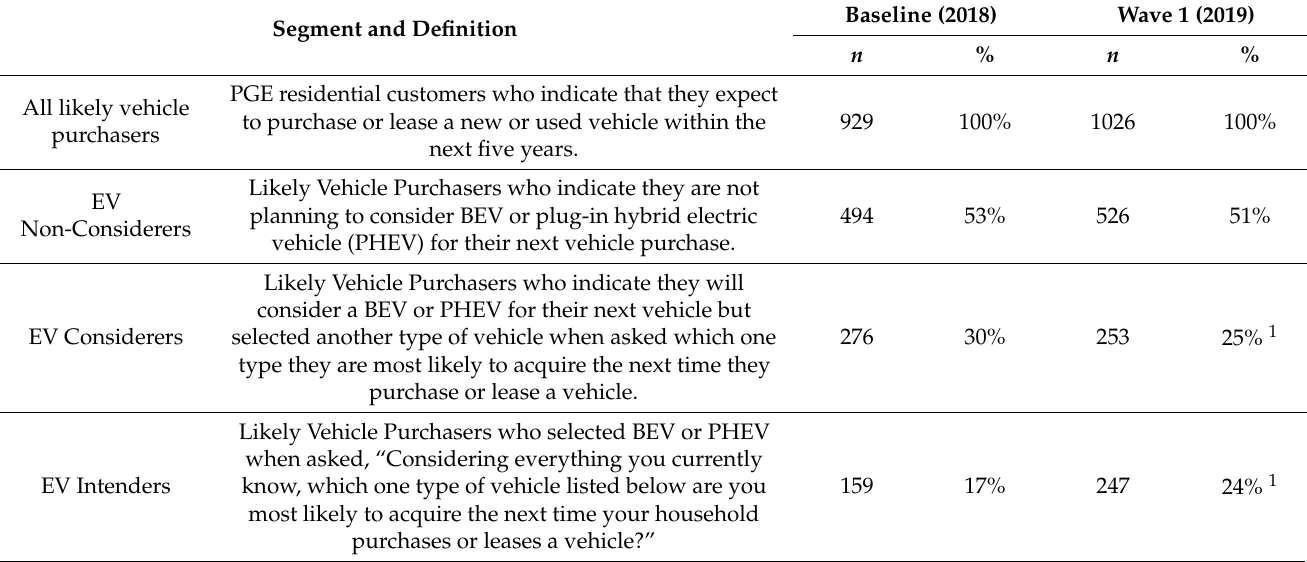
Table 1. General population customer survey analysis segments 1